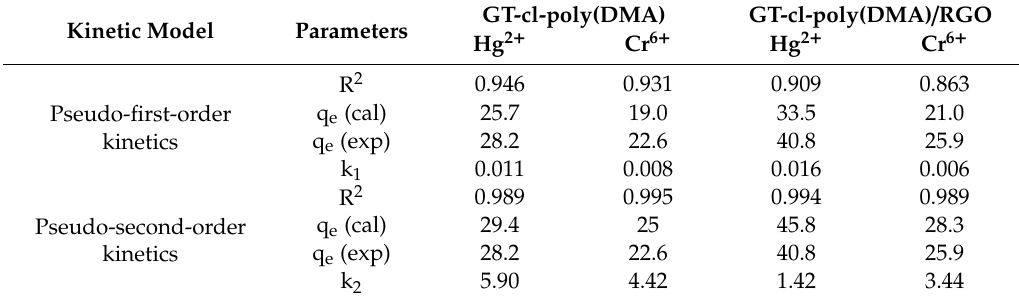
Table 4. Kinetics model parameters for Hg 2 + and Cr 6 + removal by GT-cl-poly(DMA) hydrogel and GT-cl-poly(DMA) / RGO hydrogel